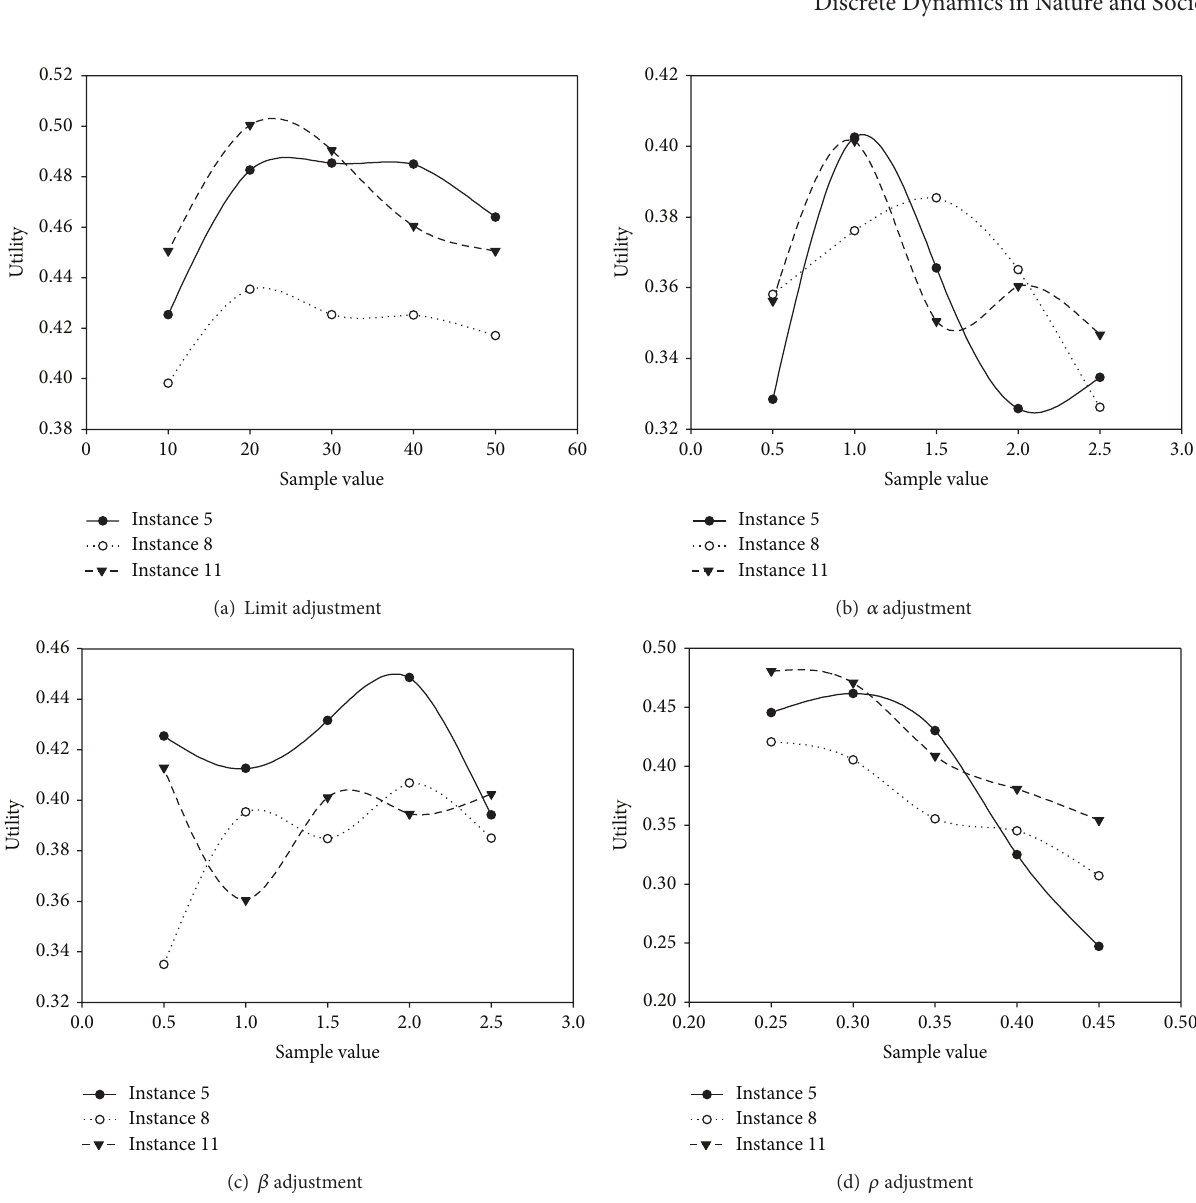
Figure 1: The effects of different parameter